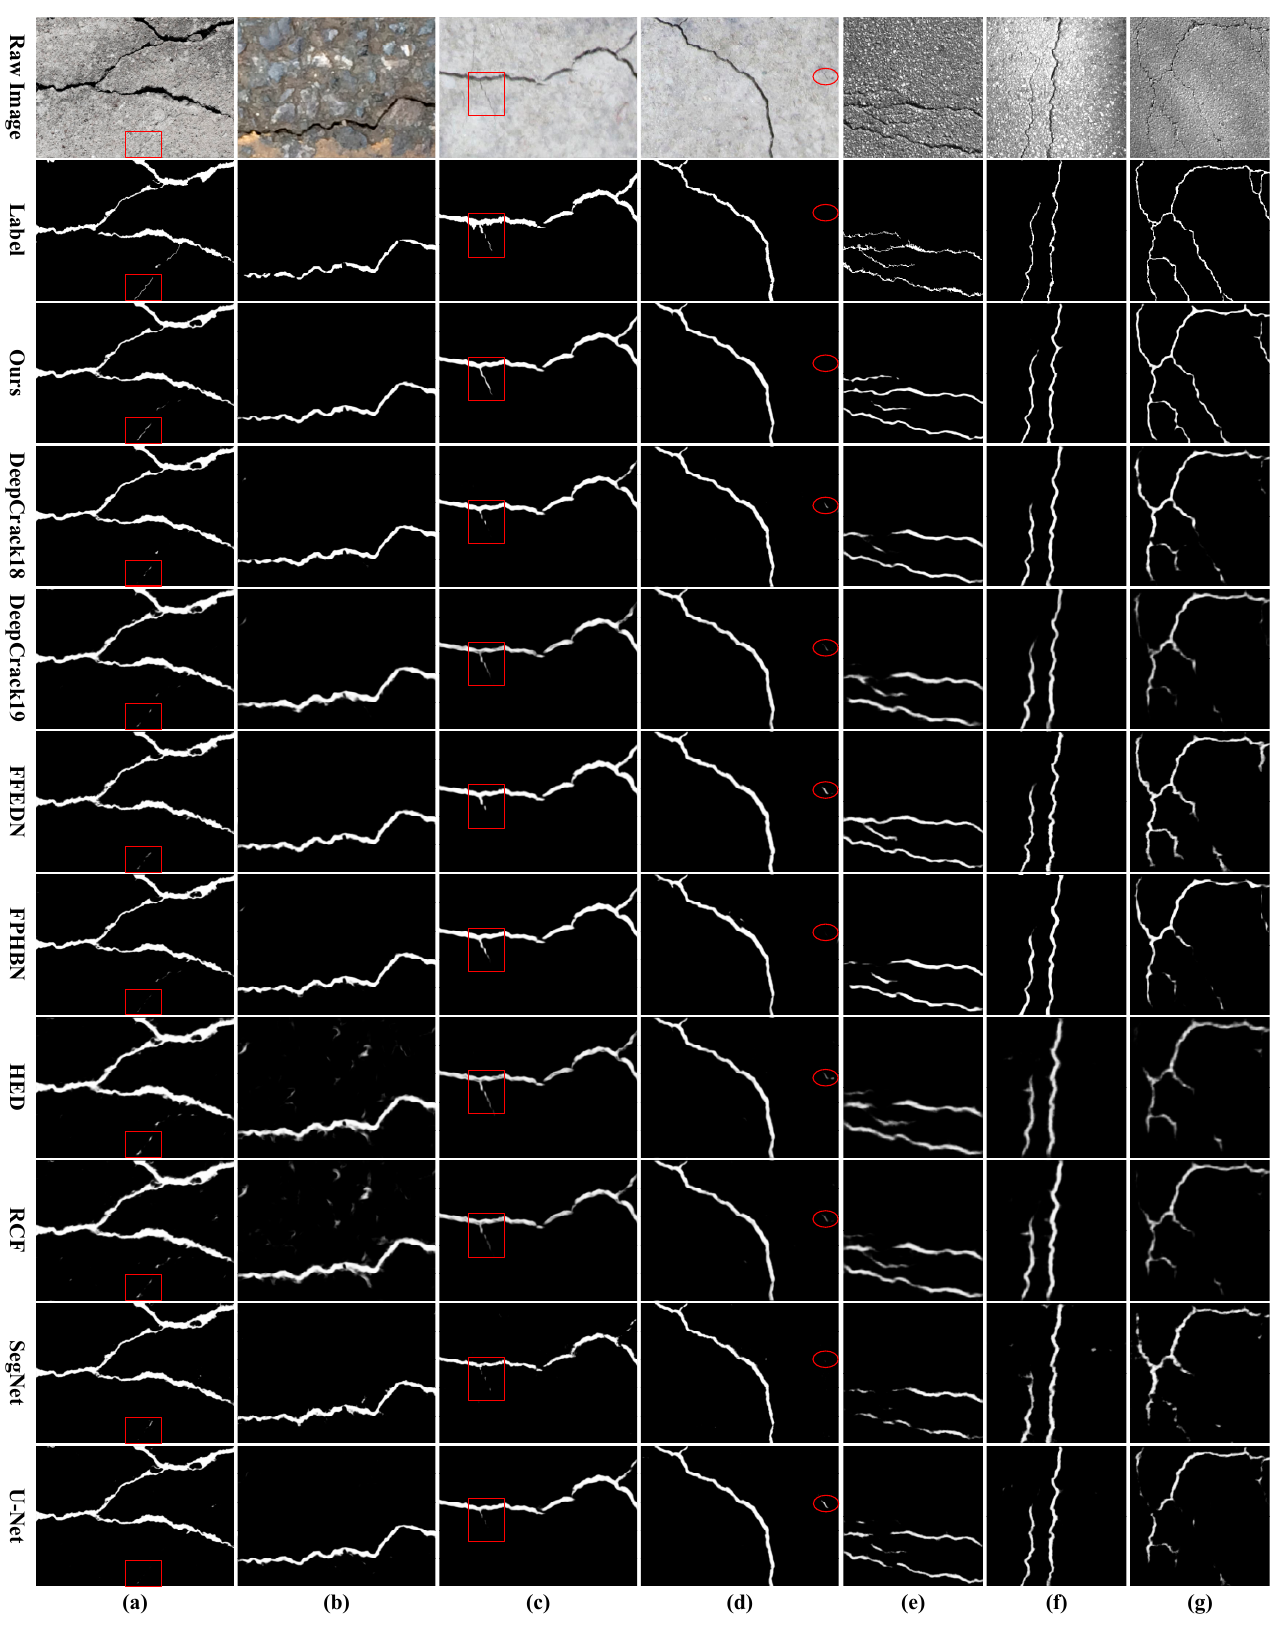
Figure 9. The crack detection results of all methods: ( a – d ) Deepcrack537 and ( e – g ) the results of the generalization study from AED.